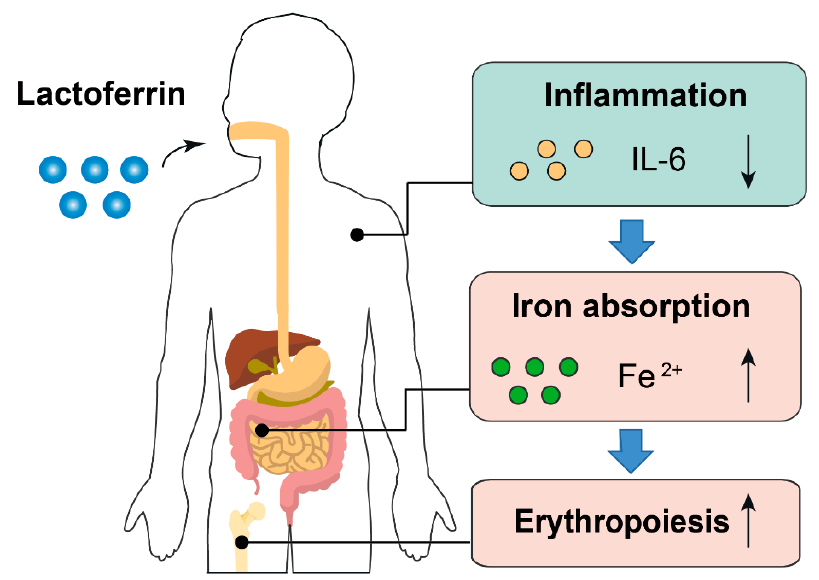
Figure 7. Proposed model describing the iron- and erythropoiesis-improving effects of lactoferrin. Part of the elements in this figure are using resources from Freepik [47] and Servier Medical Art [48] under a Creative Commons Attribution license.